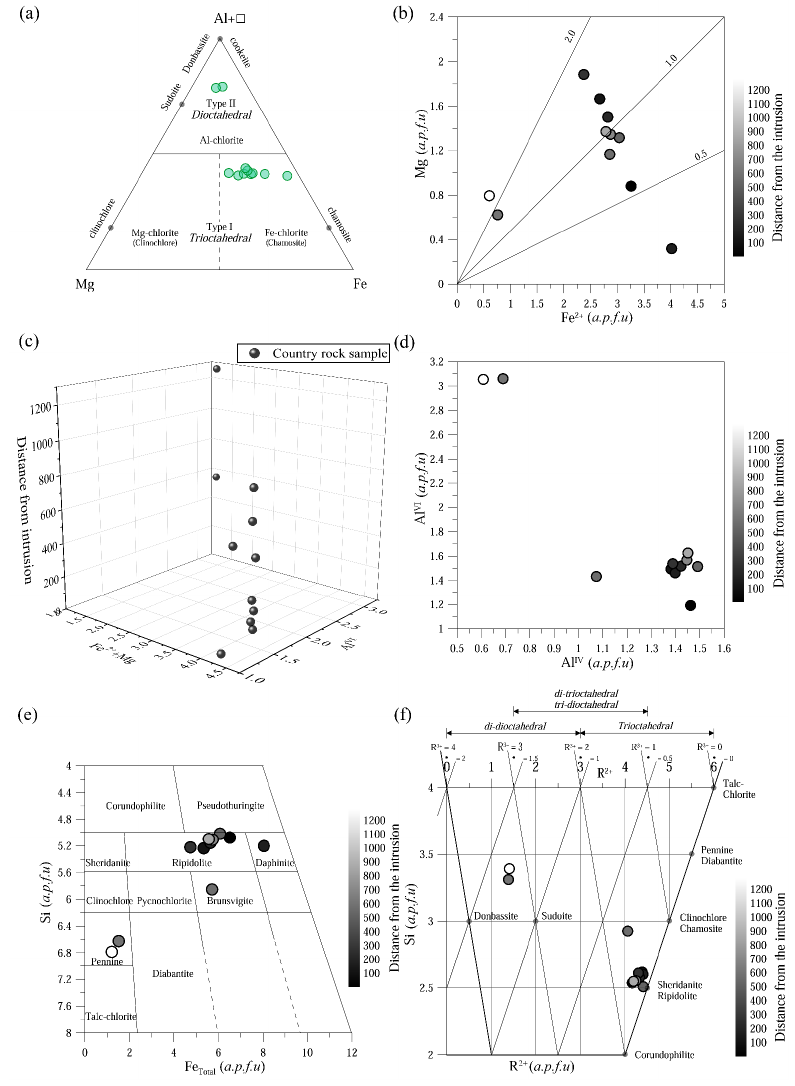
Figure 5. Chlorite chemical composition and the spatial distribution of specimens. ( a ) (Al+ (cid:3) )-Mg-Fe (after Zane and Weiss (1998) [79]; ( b ) Fe 2+ vs. Mg ( a.p.f.u ) (after Yavuz et al. (2015)) [43]; ( c ) Al VI vs. Fe 2+ +Mg vs. Distance from the intrusion; ( d ) Al VI vs. Al IV ; ( e ) Fe vs. Si ( a.p.f.u ) (Hey and Hey (1954)) [82]; ( f ) R 2+ vs. Si ( a.p.f.u ) (after Wiewi ó ra and Weiss (1990))